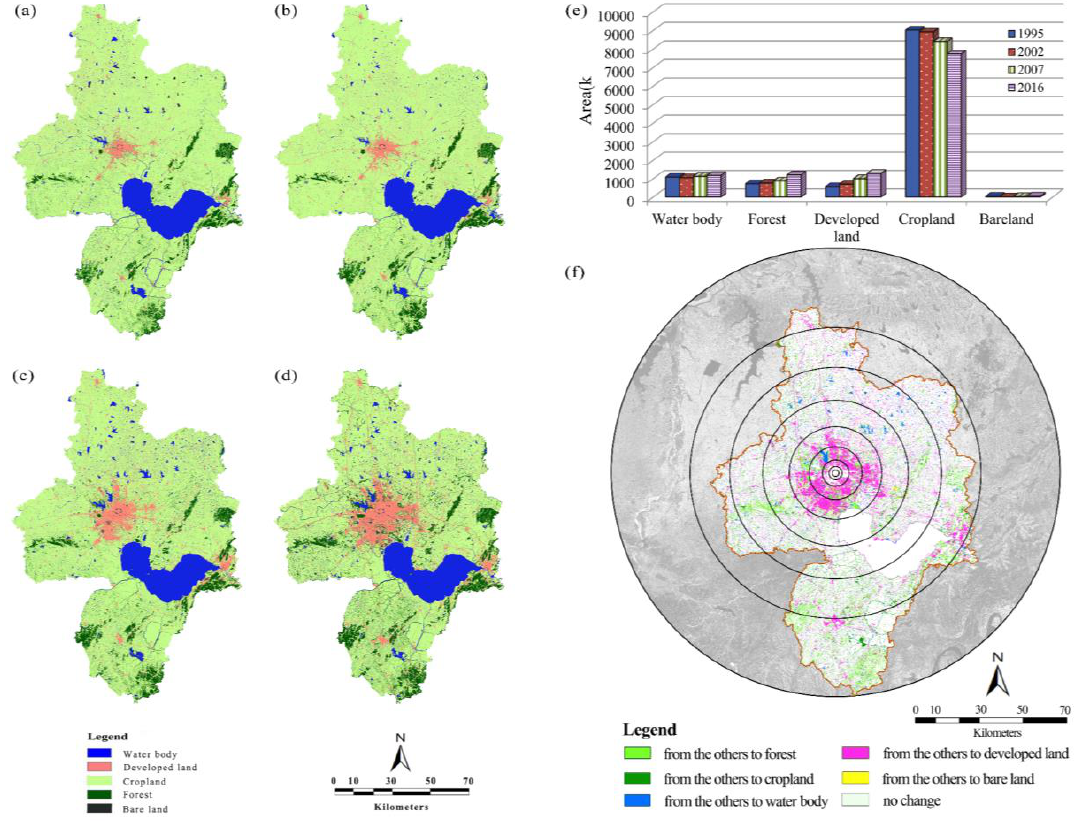
Figure 3. Land use / land cover (LULC) change in Greater Hefei during the study period. ( a – d ) show LULCs in 1995, 2002, 2007, and 2016, respectively; ( e ) shows the area of LULCs in 1995–2016; and ( f ) shows LULC conversion from other categories to the destined LULCs in 1995–2016 (Note: The concentric buffers were drawn according to the definition given in Table 2).